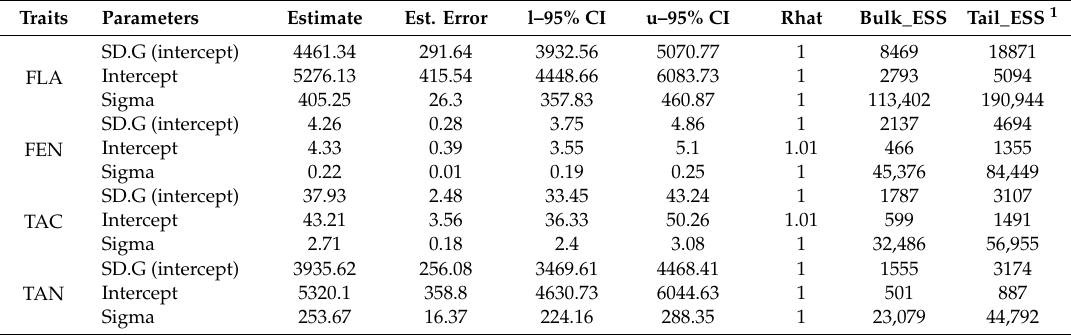
Table 1. Mean (estimate) and standard deviation (estimated error) of the posterior distributions, and the quantile-based confidence intervals.